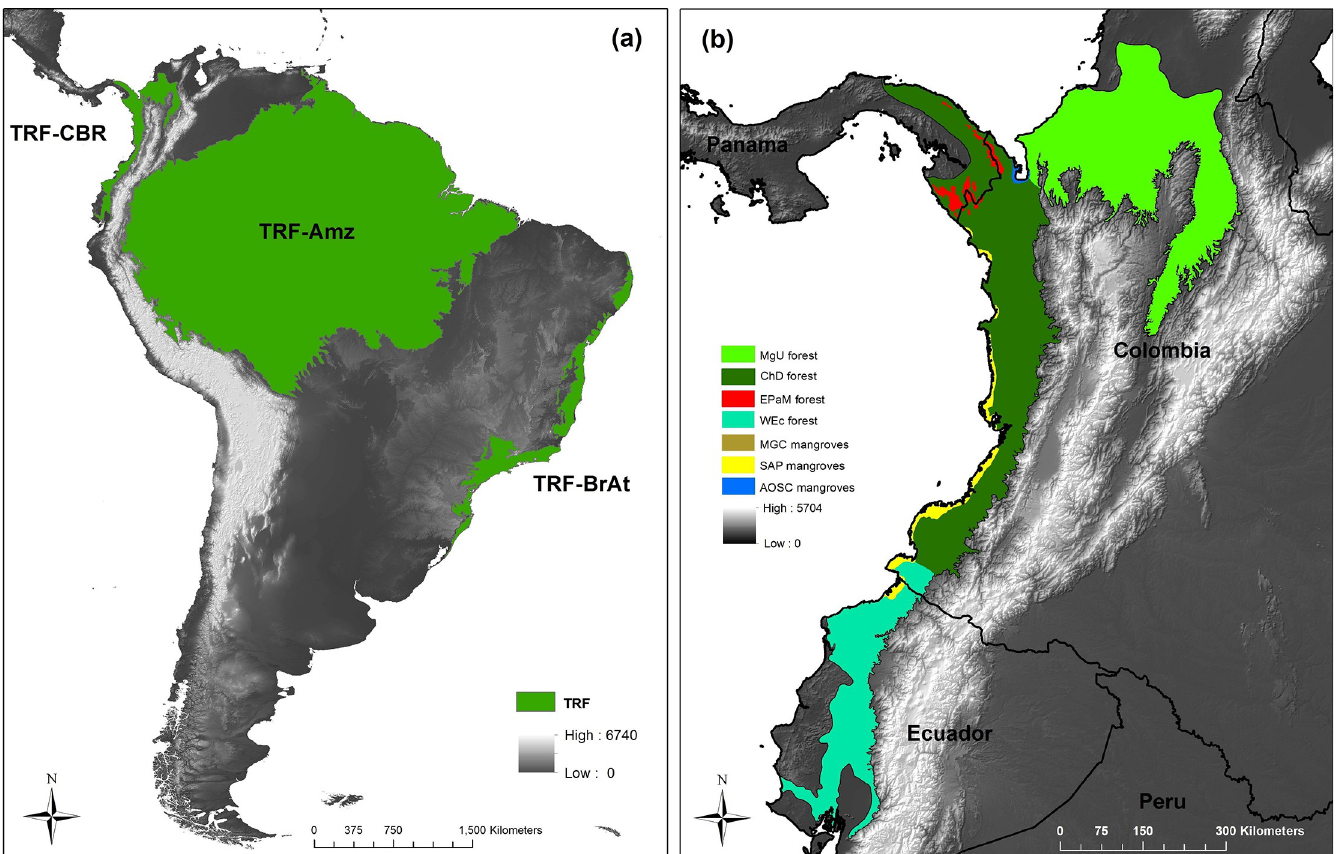
Fig 1. The Choco´-Darien Global Ecoregion (CGE): (a) estimated historical extent of Tropical Rain Forest (TRF) in South America: TRF-CGE (estimated TRF in CGE), TRF-Amz (estimated TRF in Amazon basin), and TRF-BrAt (estimated TRF in Brazilian Atlantic Forest). (b) The Choco´-Darien Global Ecoregion (CGE): This global ecoregion is formed by three smaller ecoregions: Magdalena-Uraba´ Moist forests (MgU), Choco´-Darie´n Moist Forests (ChD), and Western Ecuador Moist Forests (WEc). Other four ecoregions have small sections in the CGE: Eastern Panamanian Montane Forests (EPaM), South American Pacific (SAP) Mangrove, Amazon- Orinoco-Southern Caribbean (AOSC) Mangrove, and Mesoamerican Gulf-Caribbean (MGC) Mangrove.